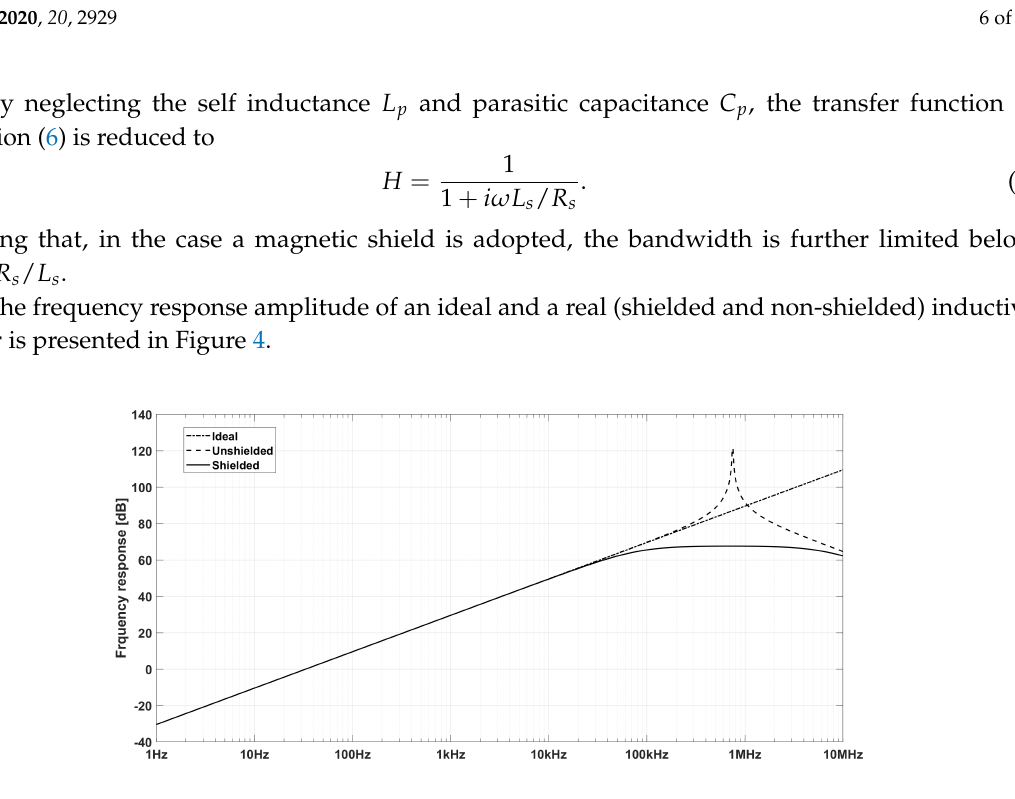
Figure 4. Frequency response of an ideal inductive sensor (dash-dotted), a real one without shielding (dashed) and a shielded one (continuous).